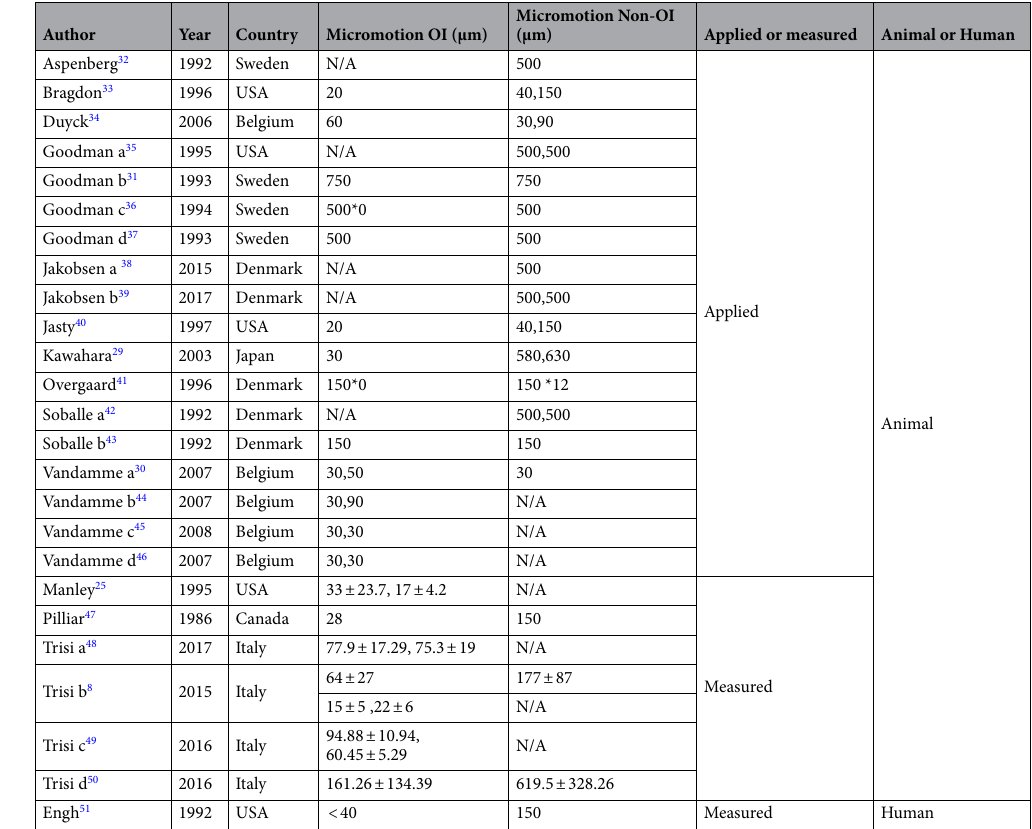
Table 1. Osseointegrated (OI) and non-osseointegrated (Non-OI) values of micromotion (µm) from the studies selected For applied values, the value was set as a controlled experimental parameter, for measured values means and standard deviation are reported where possible. *0 represents experiments with immobilized implants after a period of loading. *12 represents experiments that applied an additional implant displacement for 12